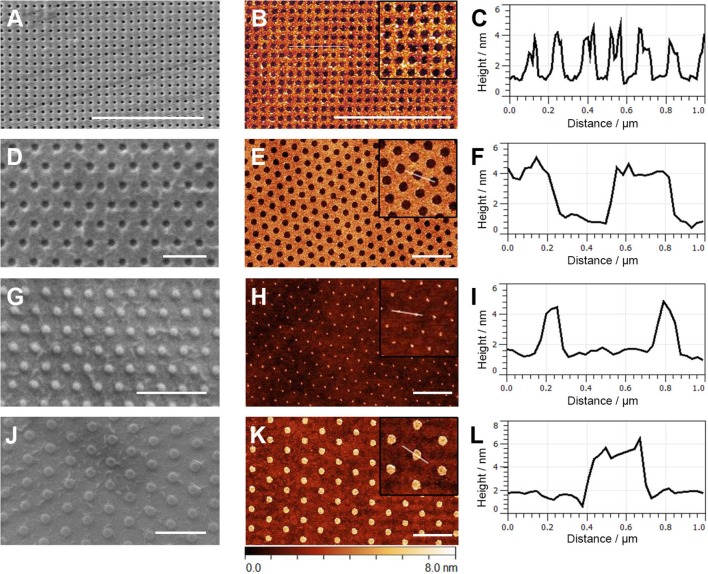
Images of the used stamps and printed BSA patterns. The first column shows SEM images of the different stamps used in this study. AFM images of printed BSA are shown in the middle column; zoom-ins are shown in the insets. The white lines correspond to the line profiles shown in the third column. The rows show data of the different stamp layouts as follows: (A–C) W80, (D–F) W300, (G–I) P80, (J–L) P300. Scale bar is 2 μm in all images.